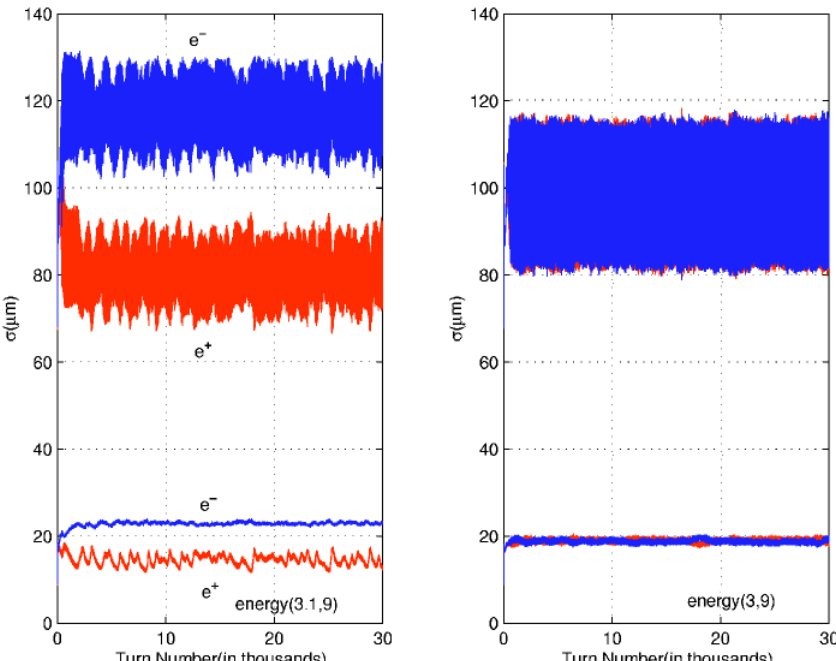
FIG. 7. (Color) Beam size vs turn number. As shown in the left-hand plot, a flip-flop solution is found with E 1 (cid:1) 3.1 GeV and E 2 (cid:1) 9.0 GeV when the energy transparency condition is violated, and in the right-hand plot the period-3 solution [6] is found with E 1 (cid:1) 3.0 GeV and E 2 (cid:1) 9.0 GeV when the energy transparency condition is